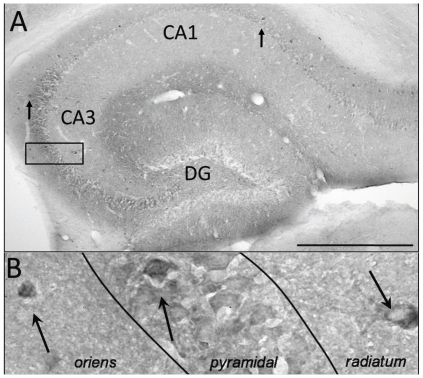
GFP+ cells found in the hippocampus of a 16 week trisomic brain.A. GFP+ cells (black cells, arrows) were most often found in CA1 and CA3. Scale bar = 500 µm. B. A magnification of the box in A, shows that GFP+ cells were found in the all three layers of CA3 (arrows).